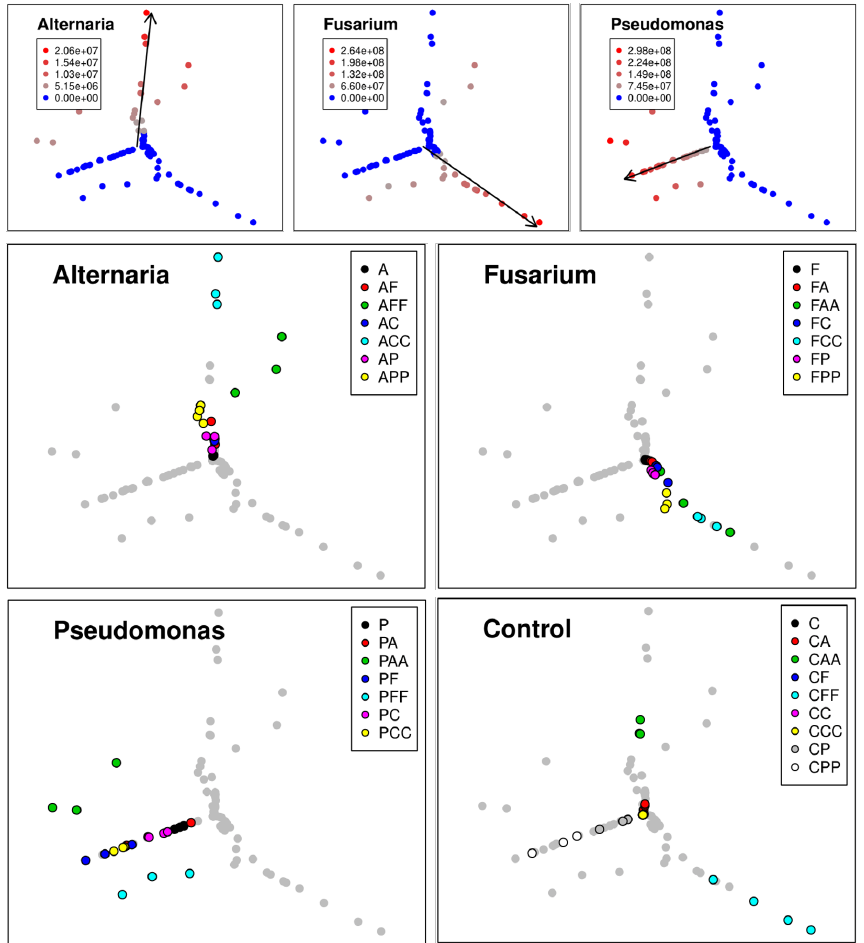
Figure 4. Abundance results of inoculation experiment illustrated in SOM-SM. Every single variant is indicated by a dot. Panels in the first row: Abundance of different genera. Black arrows indicate the direction of the steepest increase of abundance of the respective genus. Panels in lower rows: Different variants; C=control with 1/4 sterile Ringer’s solution; A= Alternaria tenuissima At 625, F= Fusarium graminearum Fg 23, P= Pseudomonas simiae Ps 9